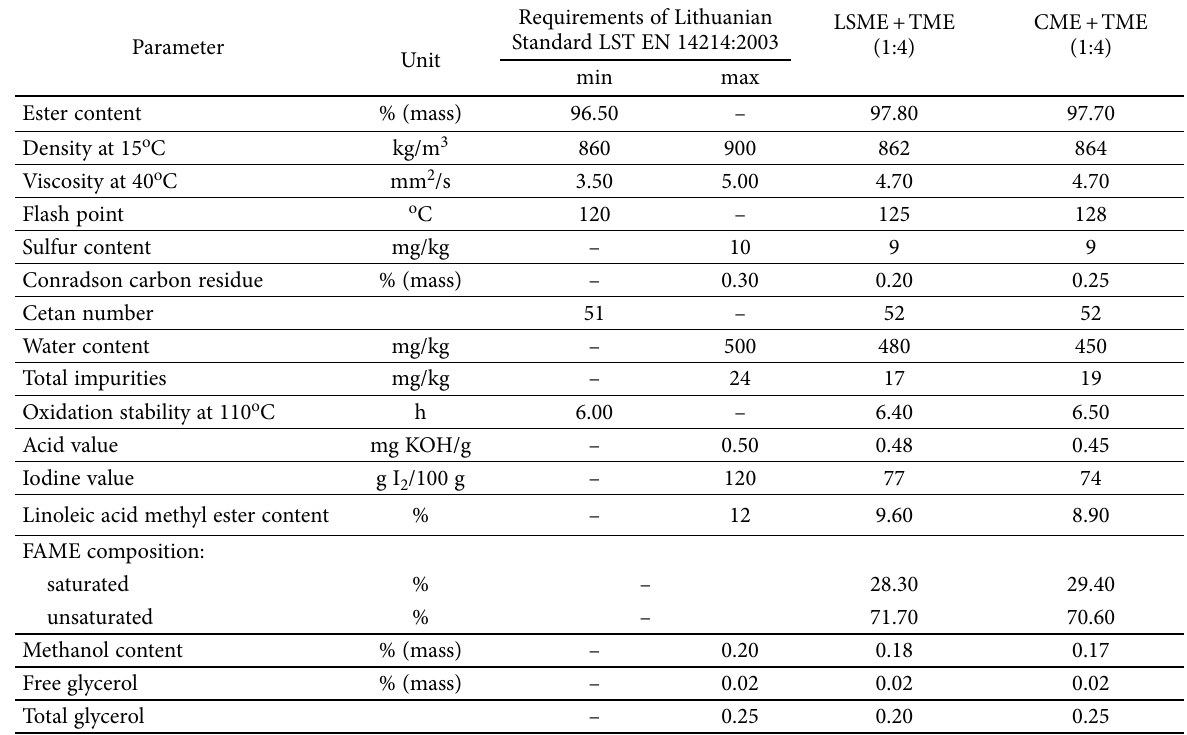
Table 1. Quality indicators for the mixtures containing CME or LSME and TME in mass proportion 1:4